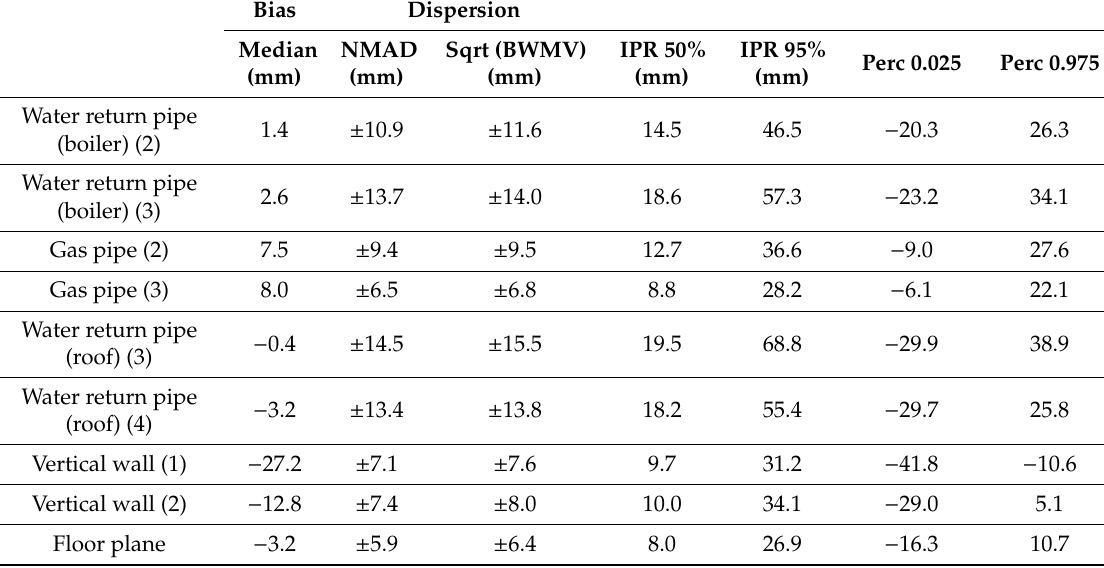
Table 8. Summary of bias and dispersion data for the analyzed regions (1–4) comparing the discrete points from Zeb-Revo with respect to the fitted surface (cylinder or plane) generated from